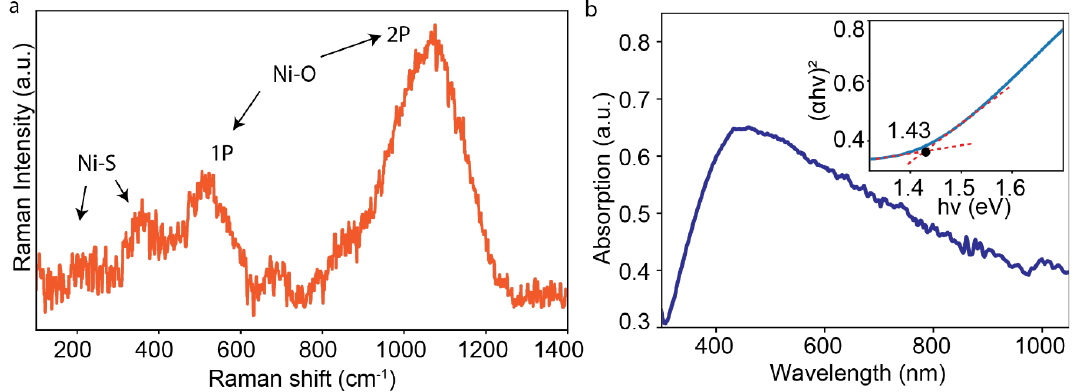
Figure 3. ( a ) Raman spectrum for nickel oxysulfide. ( b ) UV − Vis − NIR absorption spectrum and the corresponding Tauc plot shown in the inset.